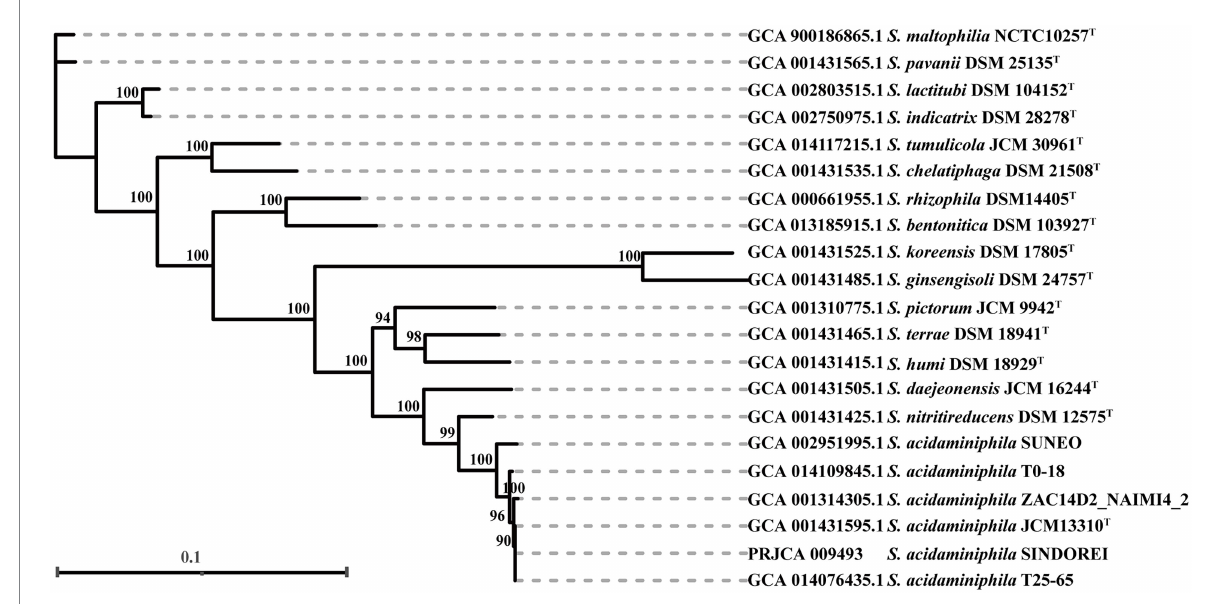
FIGURE 2 The phylogenomic tree based on the genomes of members in genus Stenotrophomonas . The numbers presenting on the branches of the tree represented the bootstrap values (based on 1,000 replicates). The scale bar indicated 0.1 substitutions per nucleotide